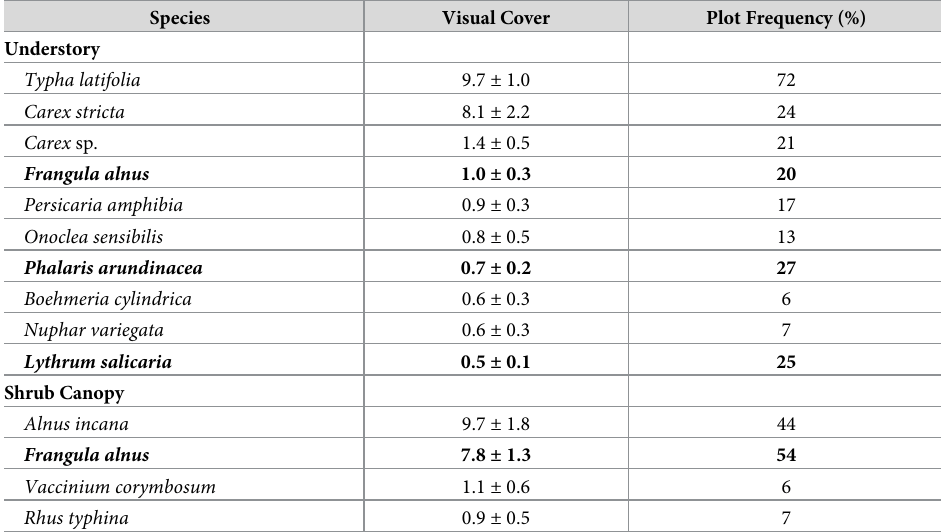
Species Visual Cover Plot Frequency (%) Understory Typha latifolia 9.7 ± 1.0 8.1 ±